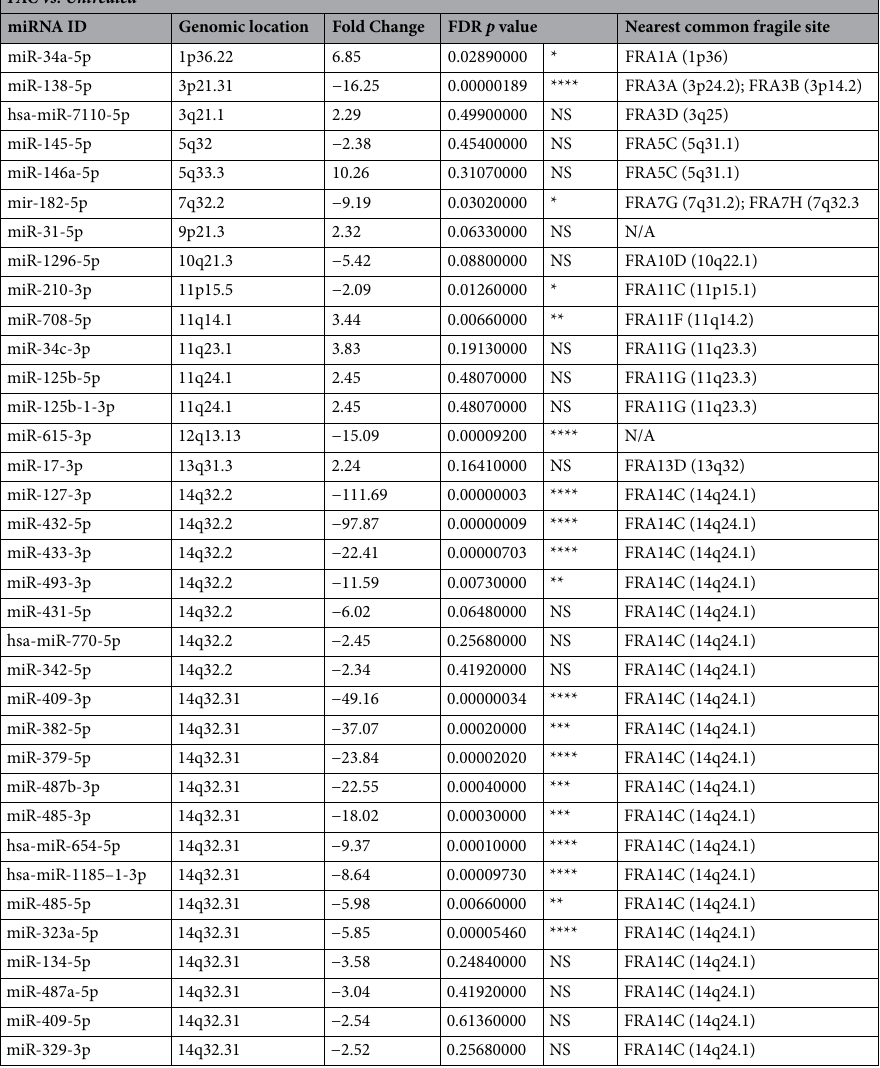
Table 1. The common fragile sites associated with the top 35 miRNA hits in FAC-exposed relative to Untreated FT194 cells are shown in this table, with > twofold change cutoff along with a FDR-adjusted